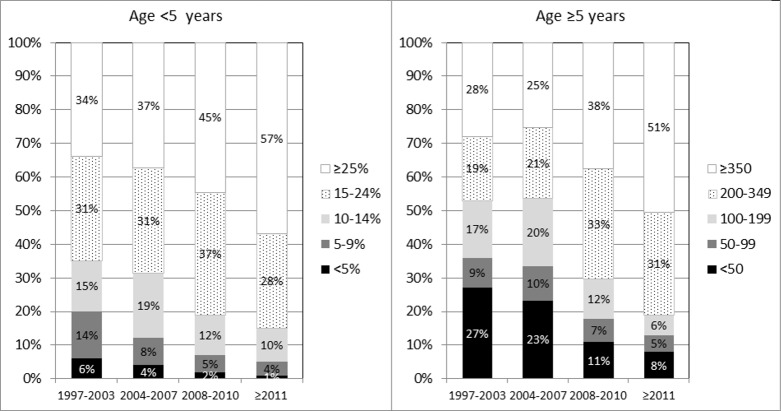
CD4% (left panel) and count (right panel) at initiation of cART, by age group and calendar period.cART, combination antiretroviral therapy; CD4%, CD4 lymphocyte percentage.